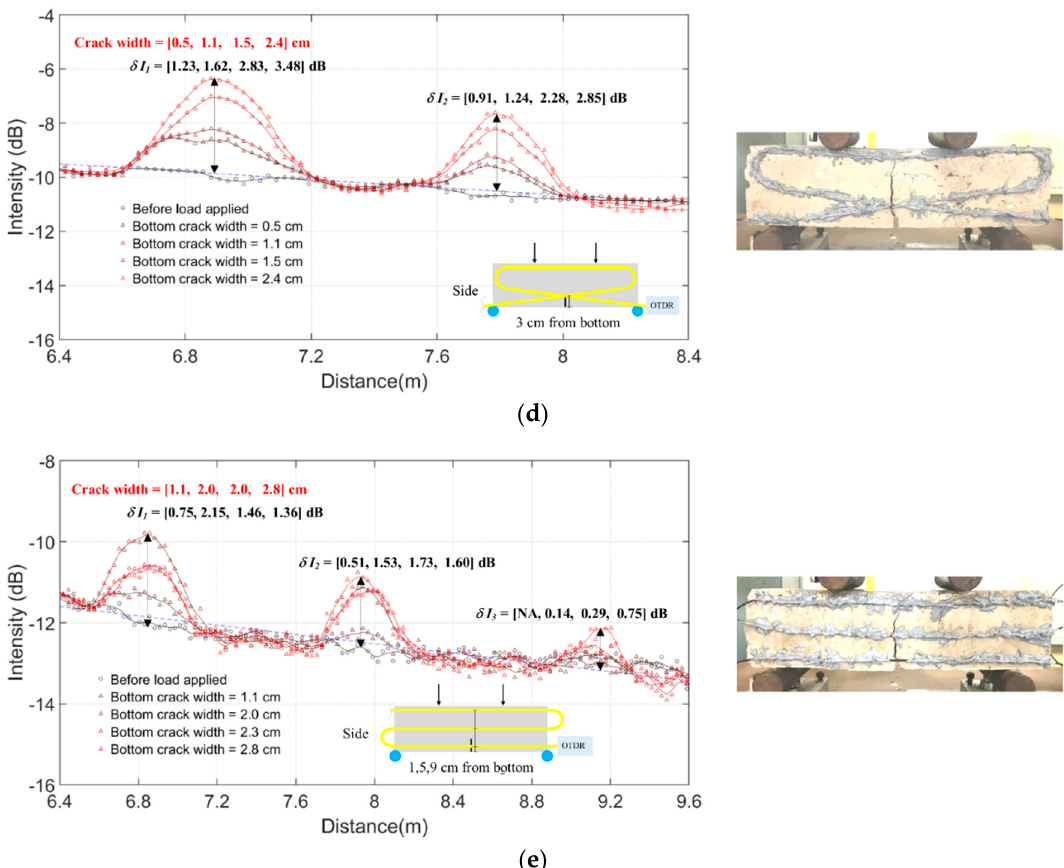
Figure 12. Monitoring of concrete beam failure in flexure: ( a ) a horizontal POF on the bottom face (specimen B); ( b ) a horizontal POF on the side face near the bottom edge (specimen SB); ( c ) a diagonal POF on the side face (specimen D); ( d ) two crossover POFs on the side face (specimen C2); ( e ) three parallel horizontal POFs on the side face (specimen S3).